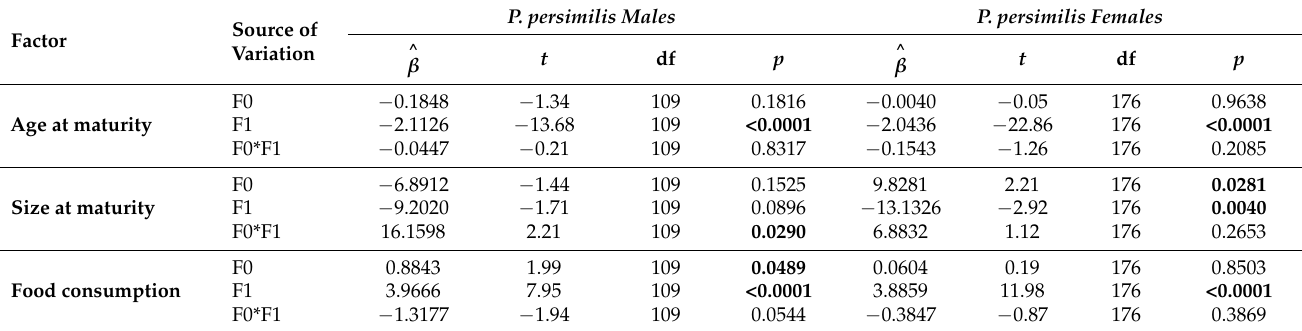
Table 2. Heat wave effects (mild or extreme heat waves) on age and size at maturity, and food consumption of offspring (F1) deriving from P. persimilis parents experiencing either mild or extreme heat wave conditions (F0). p -values in bold indicate a significant effect ( p < 0.05). Data were analyzed by a mixed ANOVA (PROC GLM in SAS) using F0 as a random factor and F1 as a fixed factor. The parameters associated with F0 ( β 1 ), F1 ( β 2 ), and F0*F1 ( β 3 ) indicate the relative contribution of non-plastic trans-generational effects (TGE), within-generational plastic effects (WGP), and trans- generational plastic effects, respectively, to the overall treatment response. A positive parameter value implies that extreme heat waves is expected to increase the trait in focus, while a negative value is expected to decrease the